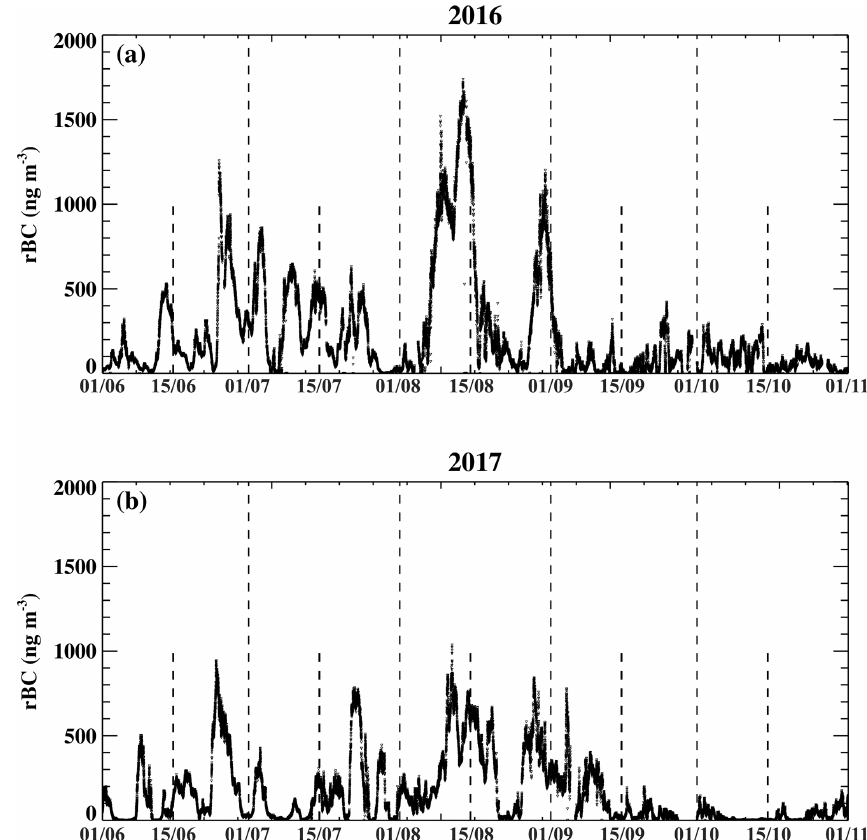
Figure 1. Time series of refractory black carbon (rBC) mass concentrations from 1 June to 31 October for (a) 2016 and (b)